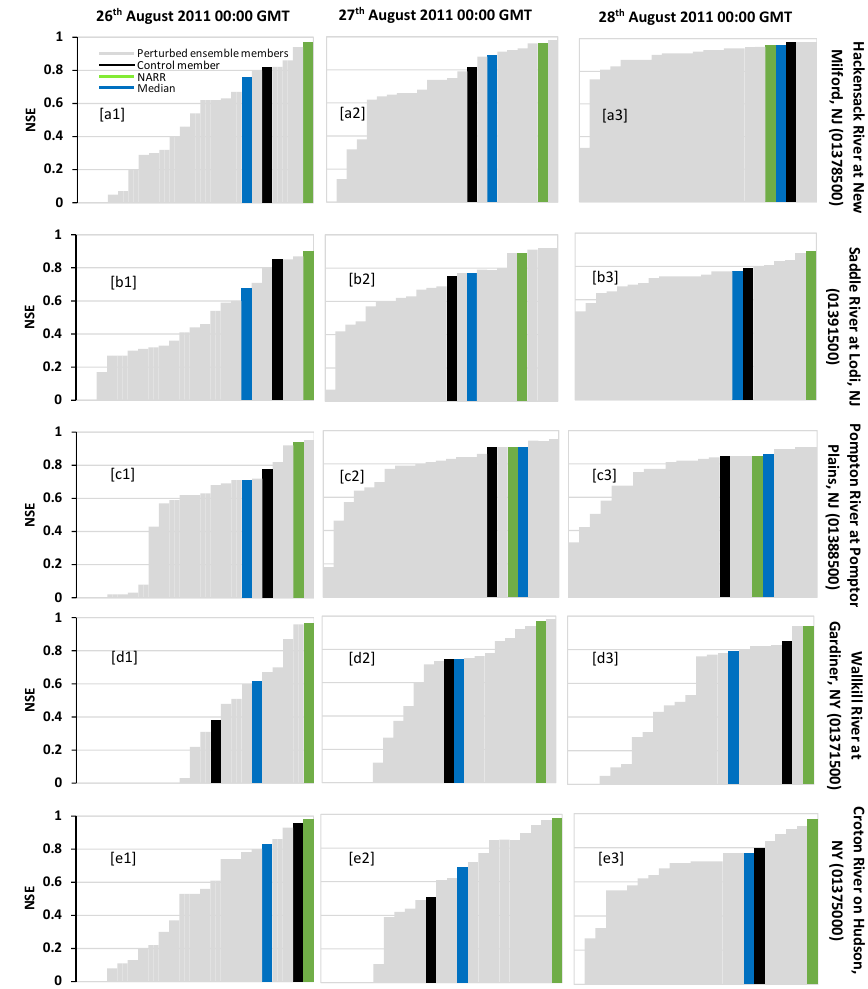
Figure 6. Models’ performance represented by Nash–Sutcliffe efficiency (NSE) at lead times of 72, 48 and 24h from the observed peak flow. The metrics are showing the NARR model outputs, the median of ensemble members and the GEFS control member. The GEFS perturbed members are shown in